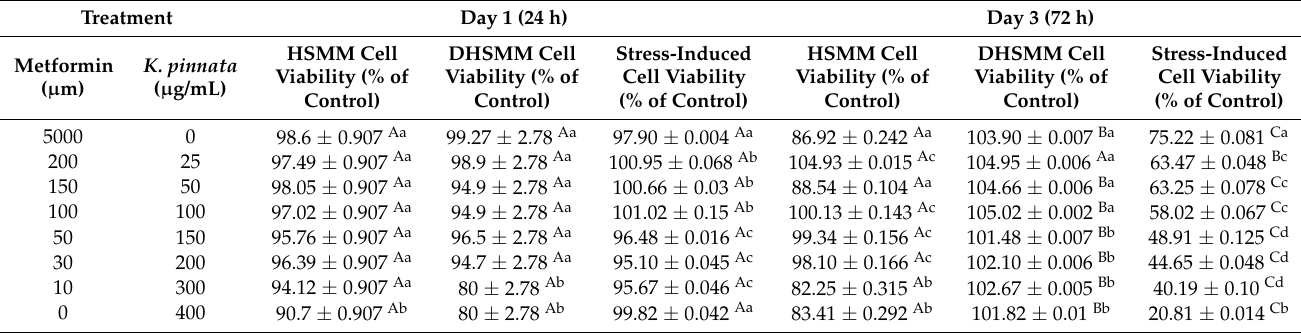
cell lines were used as comparative in vitro models. Table 1. Cell viability represented as a percentage of the control after 72 h of treatment. Data are shown as mean ± S.E.M. Significant differences are indicated by different letters (uppercase letters within row; lowercase letter within column for each treatment option) according to Tukey post hoc test ( p < 0.05): control (no treatment); human skeletal muscle myoblast (HSMM); diabetic human skeletal muscle myoblast (DHSMM).